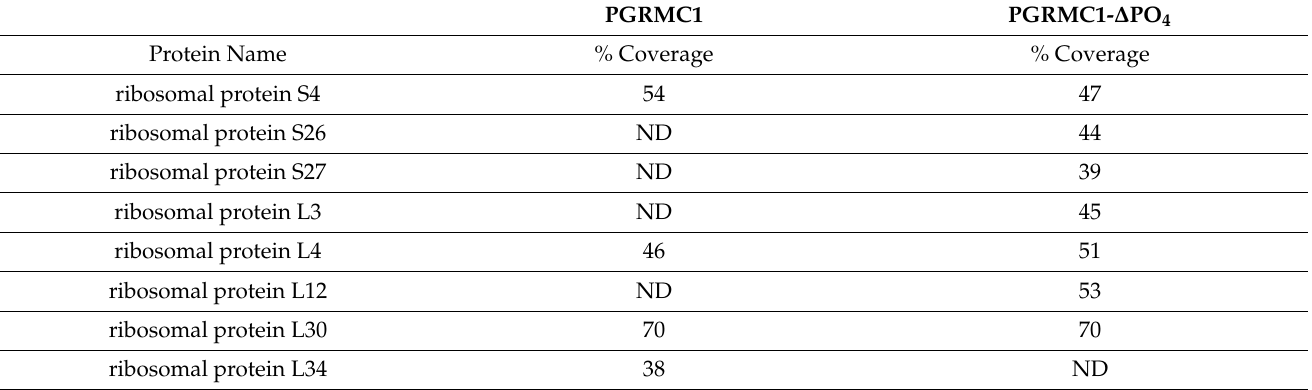
Table 2. Identification of 40s small and 60s large ribosomal proteins that interact with Flag-PGRMC1 and Flag-PGRMC1 in which serine 57 and 181 were changed to alanine (i.e., ∆ PO 4 ) in spontaneously immortalized granulosa cells as per previously described protocol [36]. The list of proteins with each protein having at least 10% protein coverage and two or more unique peptides assigned to each protein. ND = not detected ( ≤ 1 peptide fragment detected). (Peluso unpublished